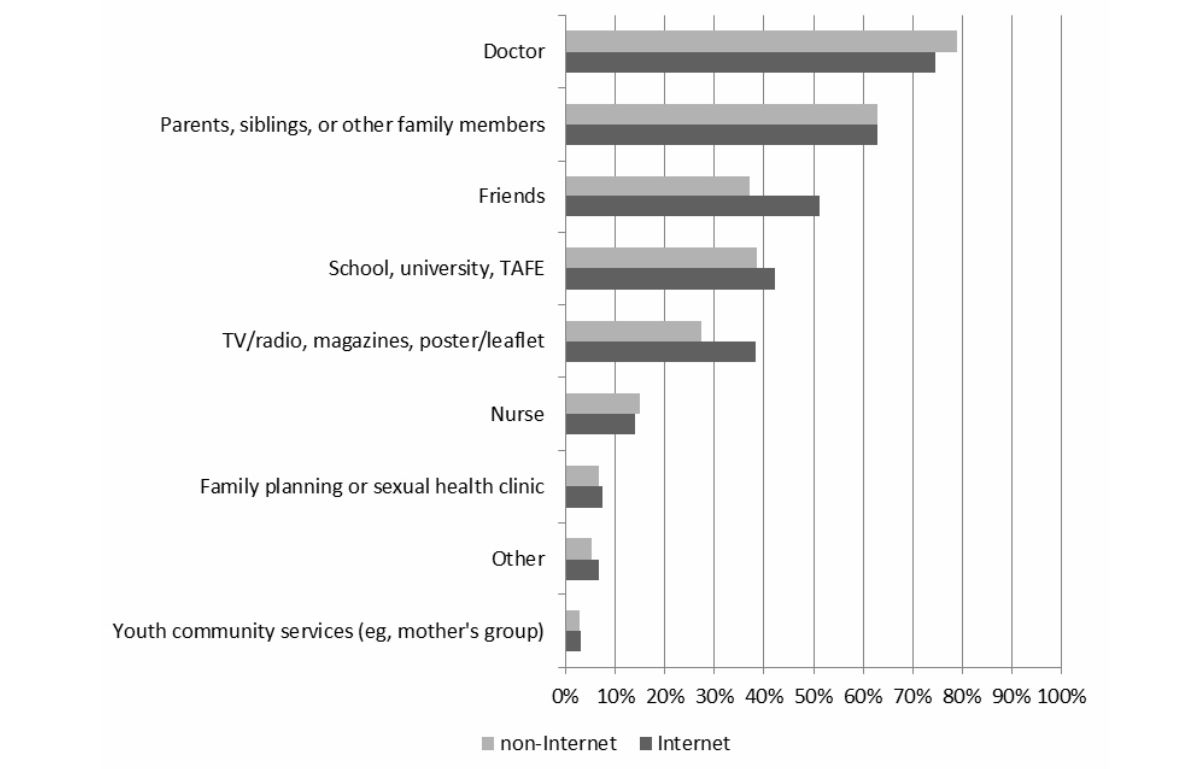
Figure 1. Sources of health information accessed by young women who do and do not use the Internet as a health information